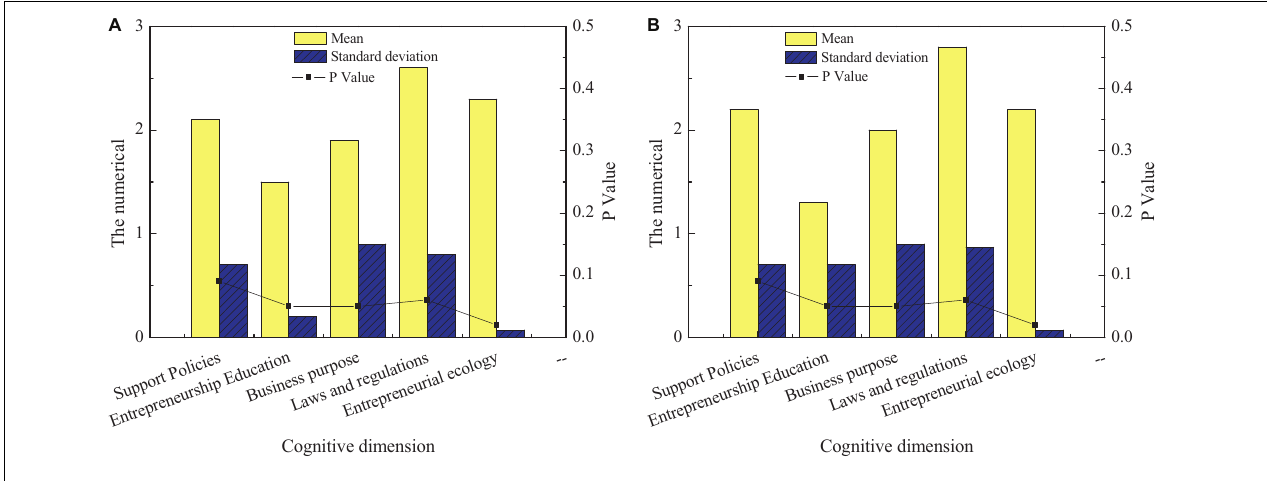
FIGURE 5 | Comparison of students’ entrepreneurial cognition of intangible cultural heritage in different disciplines: (A) liberal arts and (B) science.